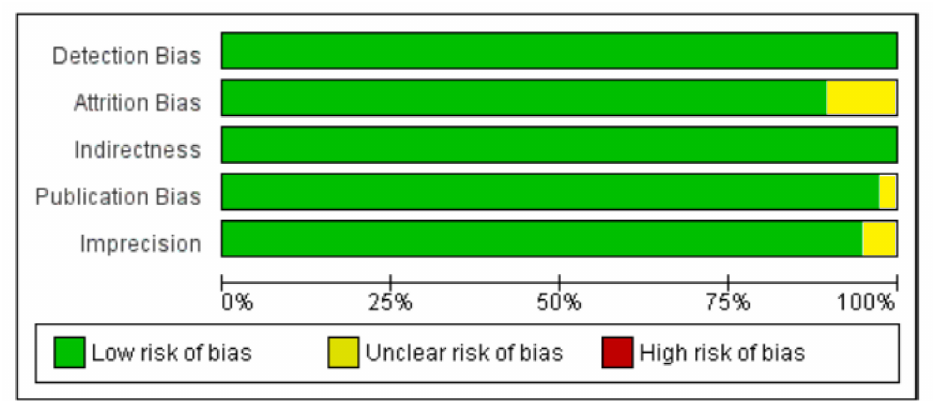
Figure 9. Author’s assessment of the risk of bias in non-diabetic subject studies: Data shown in percentages for all